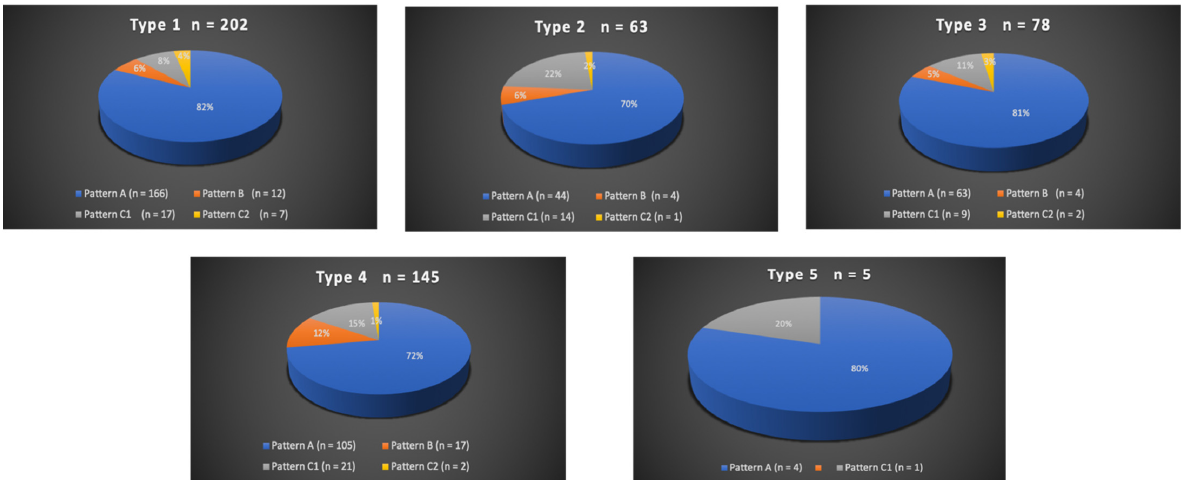
Figure 3. Distribution in study cohort of the origins of the solitary prostatic arteries according to the different patterns. Types 1 to 5 represent the possible origins of the prostatic artery (PA), according to the Assis classification. The values are presented as a number, n . Patterns A, B, and C1 and C2 correspond to the different intra/extra-prostatic supplies of the prostatic artery in case of a solitary PA (one artery per side, n = 493/622 (79.3%) in this study), according to the Amouyal classification. The values are presented as a number ( n ) and %.